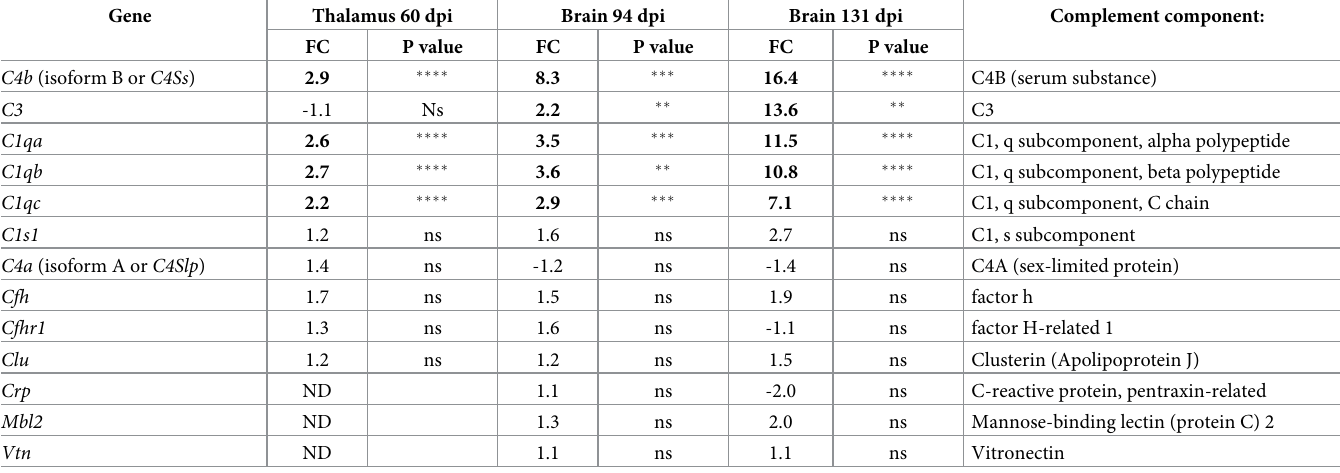
Table 1. Screen for temporal changes in gene expression associated with the complement cascade and activation during infection with scrapie strain 22L.